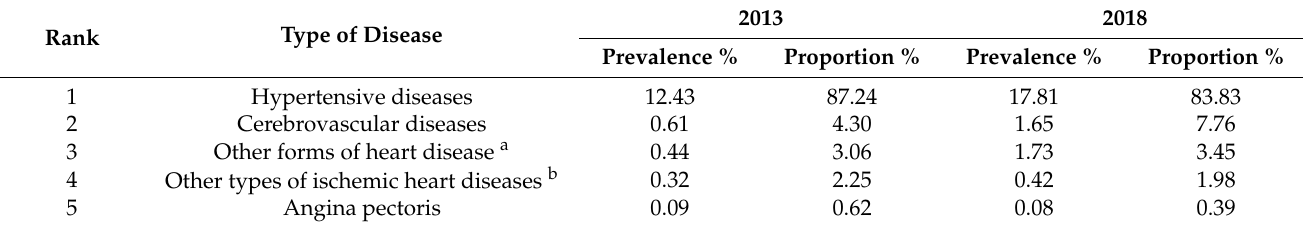
Table 3. Top five circulatory system diseases (CSDs) of inhabitants between 2013 and 2018 in Hunan Province, China. Rank Type of